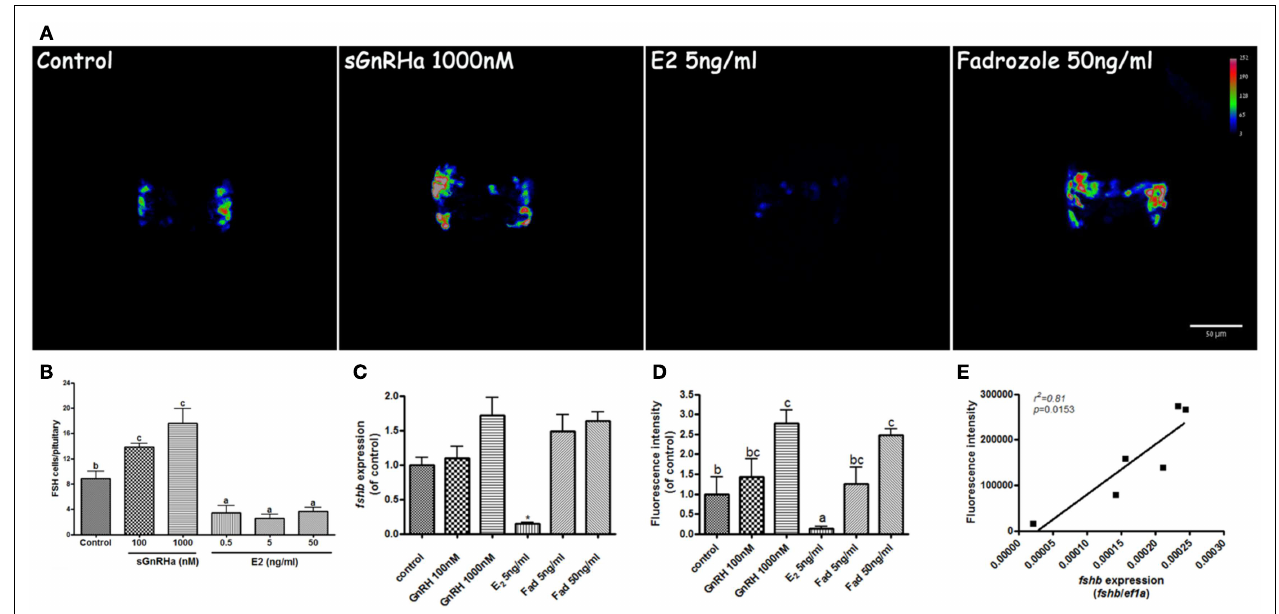
treatments effects on number of labeled cells per pituitary. GnRH increased and E 2 decreased the number of fluorescent cells per pituitary. (C) Real-time quantification of the treatment effect on fshb gene expression also shows a significant decrease in the estradiol treatment. (D) Quantification of the treatment effect on fluorescent signal intensity shows an increase at the high doses of GnRH and fadrozole and a significant decrease in the estradiol treatment. (E) Correlation analysis of fshb expression and EGFP fluorescent signal intensity.